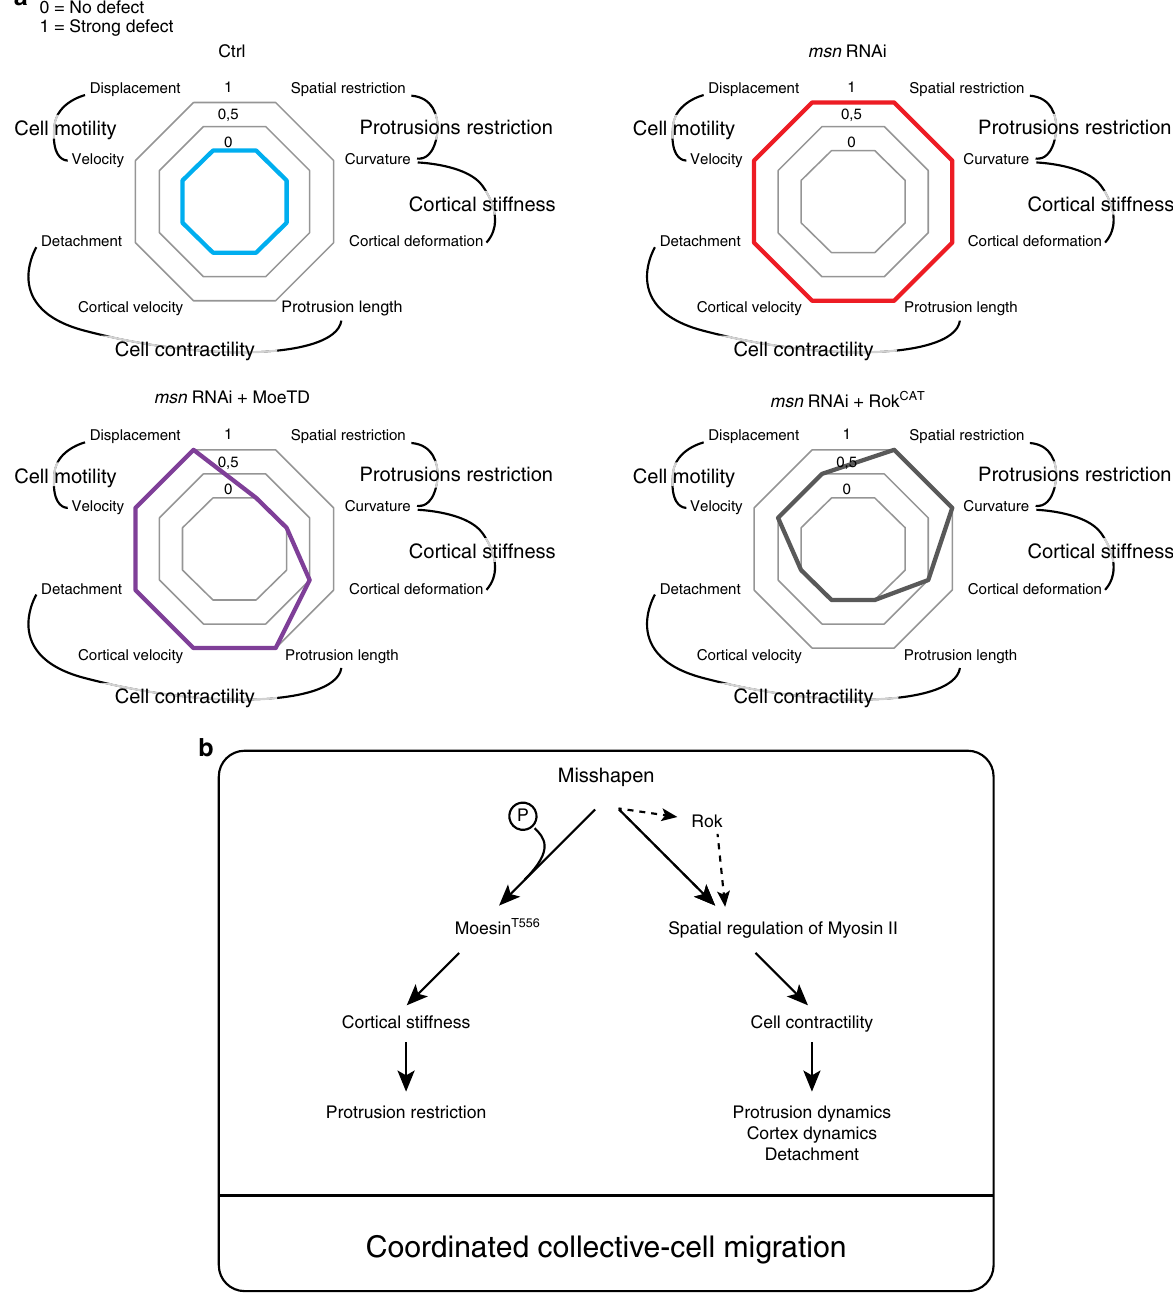
Fig. 8 Model. a Schematic representation of the phenotypes observed in control conditions, after depletion of Msn or in Msn-depleted clusters expressing Moe T556D or Rok CAT . Phenotypes were scored on a scale of 0 to 1, where 0 is the wild-type phenotype and 1 stands for a strong defects observed after Msn depletion. We categorized each readout into four main categories being Protrusion restriction, Cortical tension, Cell contractility, and Cell Motility. Active Moe (Moe T556D ) rescues parameters associated with cell communication and partially rescues Msn depletion-induced cell shape defects. Conversely, Rok CAT expression rescues cell contractility and partially restores cell motility but not cell communication. b Working model. The kinase Misshapen regulates cortical stiffness and protrusion restriction by directly phosphorylating Moesin. Independently, Misshapen regulates cluster detachment